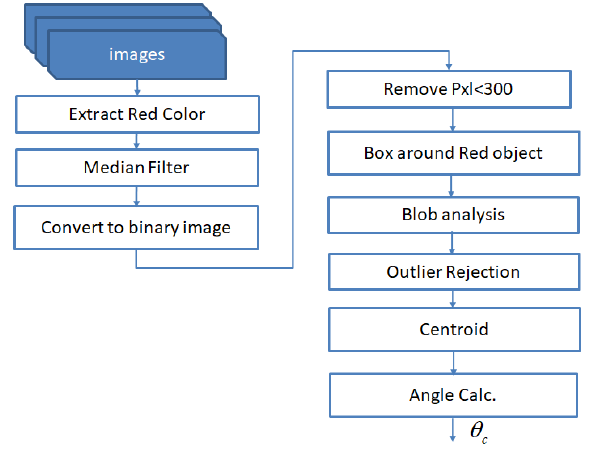
Figure 11. A flowchart to calculate vision-based